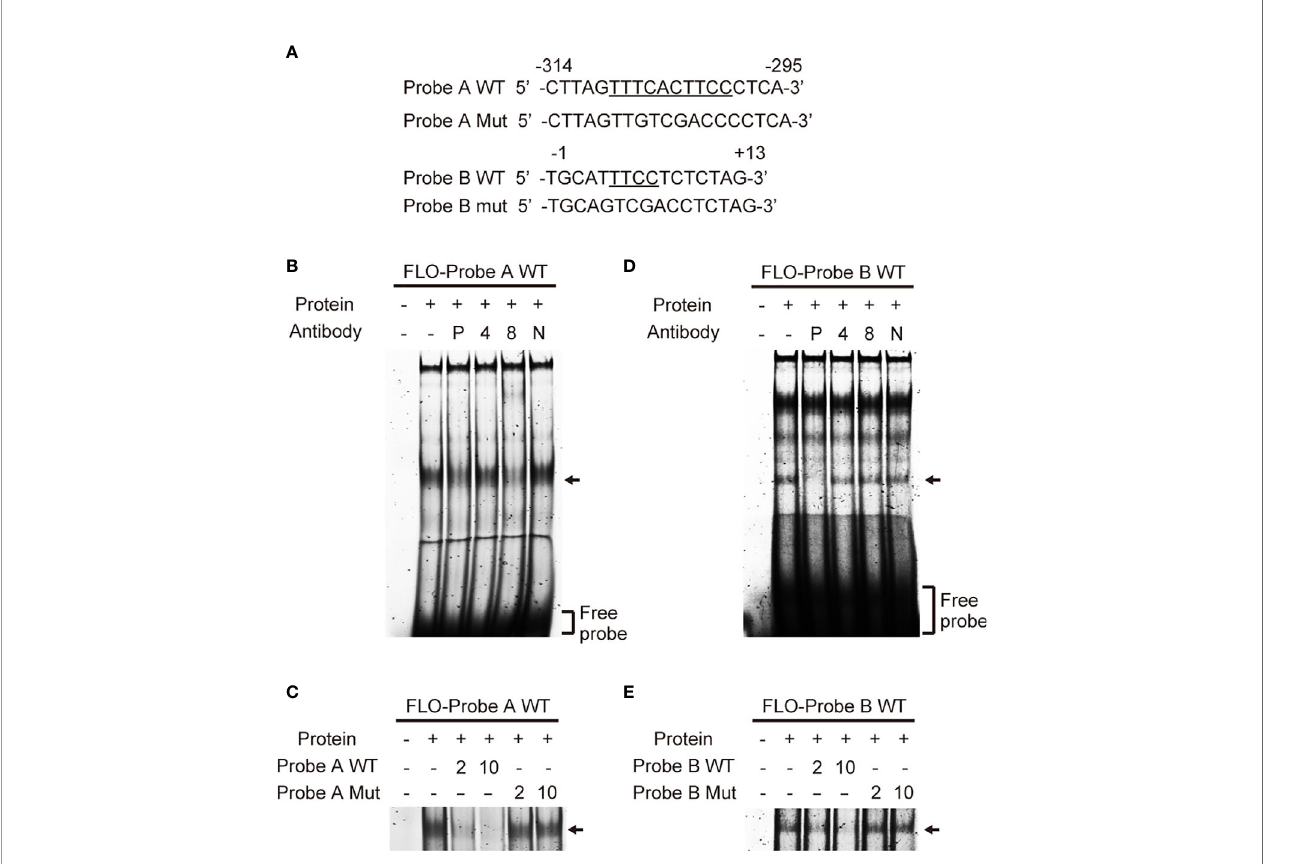
FIGURE 3 | Identi fi cation of transcription factors that bind to the cis -elements. (A) Sequences of the probes used in electrophoretic mobility shift assay. (B, D) Fluorescein (FLO)-labeled probe A (B) or B (D) were incubated with nuclear extracts of THP-1 cells in the presence of anti-PU.1 (P), anti-IRF4 (4), anti-IRF8 (8) or nonspeci fi c (N) antibodies. (C, E) FLO-labeled probe A (C) or B (E) were incubated with nuclear extracts of THP-1 cells in the presence of 2- or 10-fold amounts of unlabeled wild-type or mutated oligonucleotides. After electrophoresis on 5% acrylamide gels, fl uorescence was